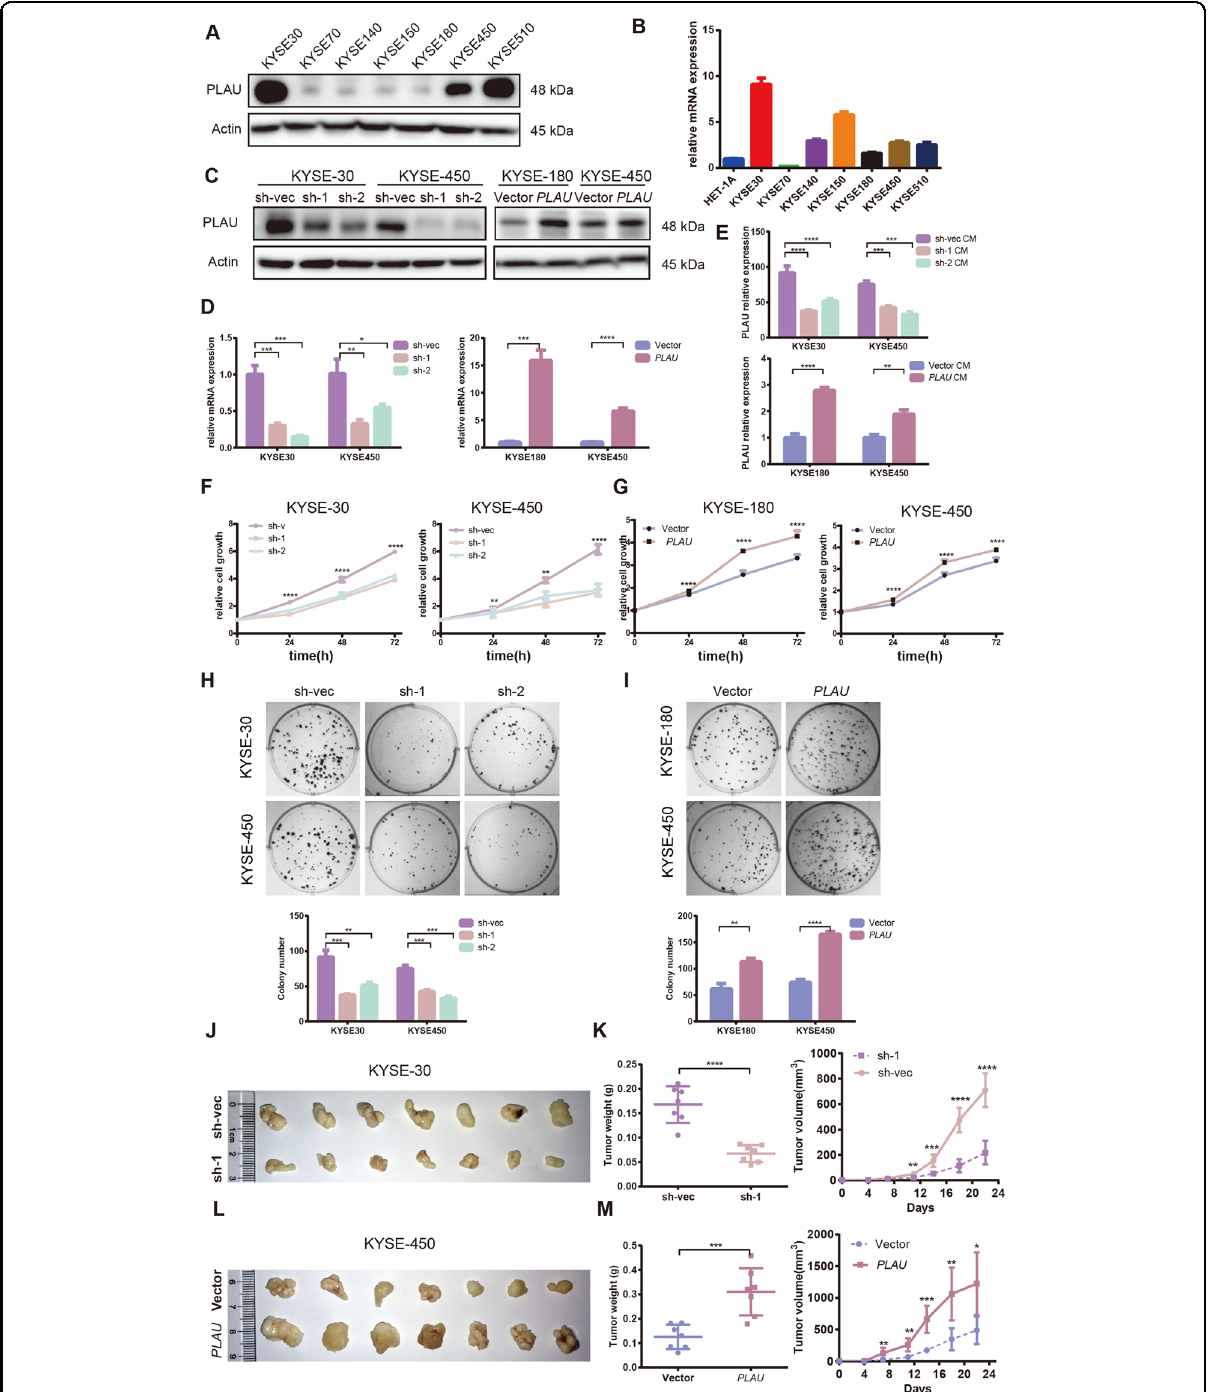
Fig. 2 PLAU was critical for ESCC cell proliferation and tumor growth. A , B Expression of PLAU in seven ESCC cell lines at the protein and RNA level (relative to HET-1A). C – E PLAU knockdown or overexpression in ESCC cells was veri fi ed by western blot ( C ), RT-qPCR ( D ), and ELISA (E). F , G Rate of cell growth of sh PLAU -1, sh PLAU -2 and sh-vec KYSE-30 and KYSE-450 cells and PLAU overexpressing and vector control cells were measured by CCK8 assays. H , I Colony formation of PLAU knockdown and overexpression KYSE-30, KYSE-450, and KYSE-180 cells. Colony numbers were compared between the groups. J – M Photos, weights, and growth curves of tumors in nude mice subcutaneously inoculated with sh PLAU -1 and sh-vec KYSE-30 cells ( J , K ) or PLAU overexpressing or control cells ( L , M ) (female 6-week-old to 8-week-old nude mice, n = 7 per group). Three biological replicates were performed for in vitro assays. Data in bar charts are presented as the mean ± SD. * P < 0.05, ** P < 0.01, *** P < 0.001, **** P < 0.0001 (Student ’ s t